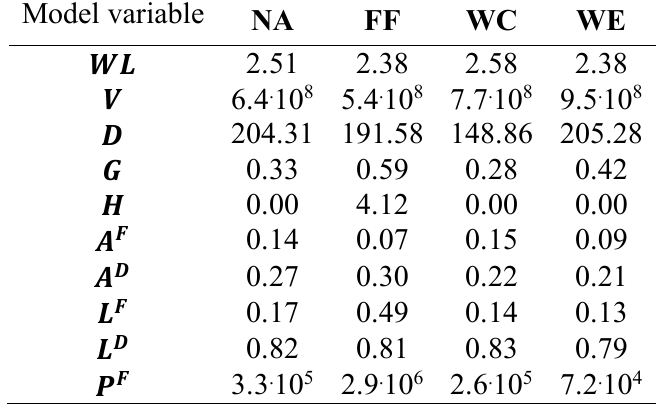
Table A5. Average values of different model variables obtained for the synthetic experiment additional scenario #4 with dam construction and four water management strategies (NA: No Actions; FF: Fighting Floods; WC: Water Conservation; WE: Water